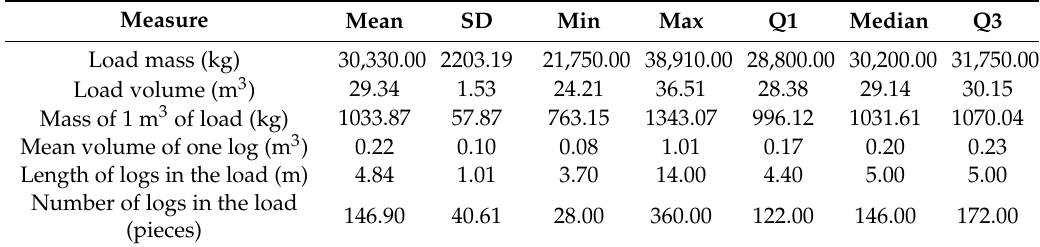
Table 2. List of selected characteristics of timber